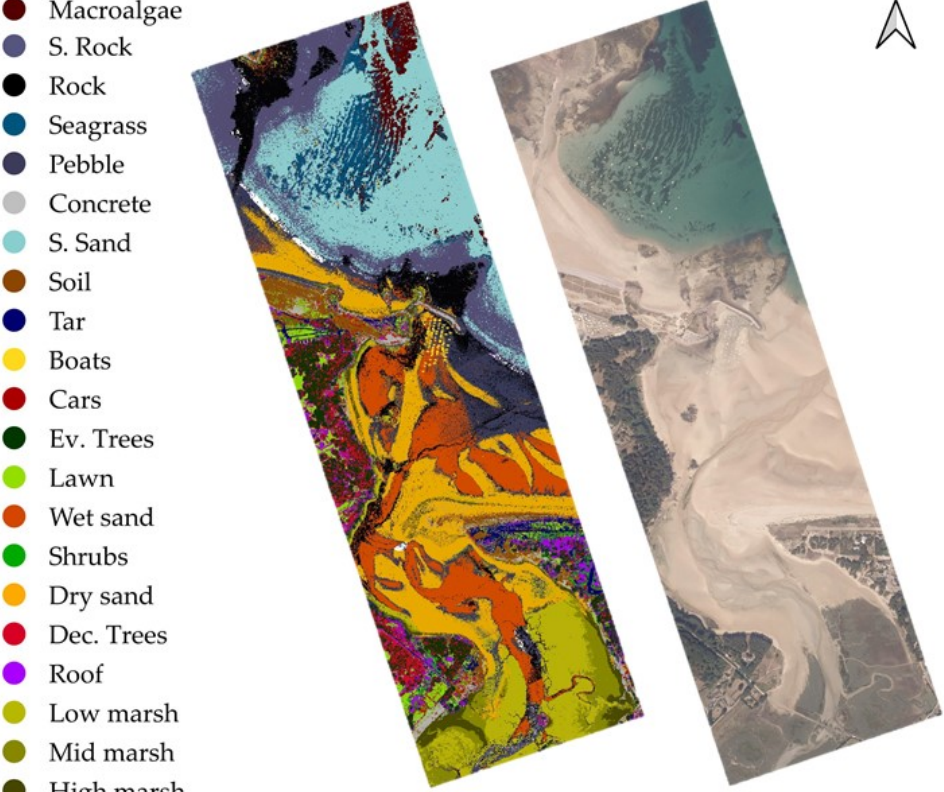
Figure 9. Projected 3D map of the habitats obtained with the predictions of a random forest classifier on green spectral features, infrared intensities, and elevation values; orthoimage of the study area. The orthoimage was captured in 2014, while lidar data are not contemporaneous as they date from 2019. S. = submerged, Ev. = evergreen, Dec. = deciduous.